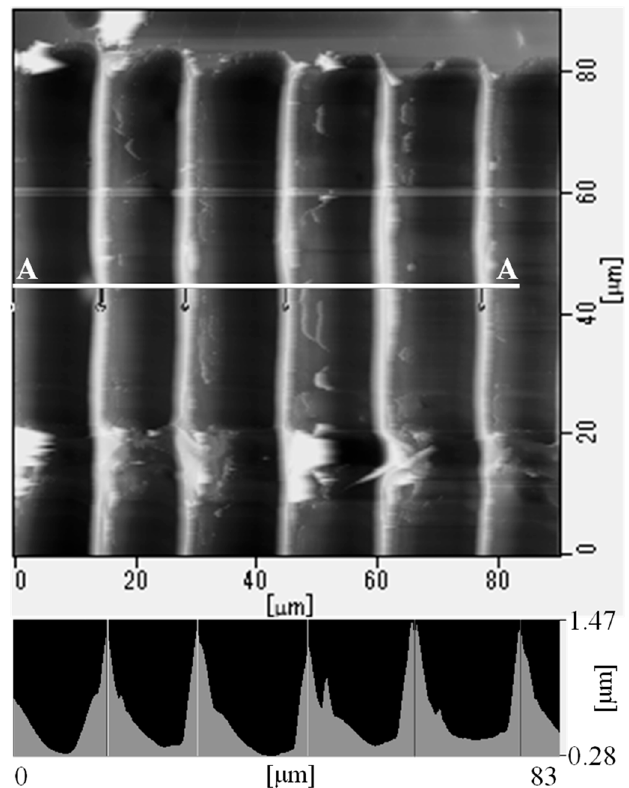
Figure 4. SPM images of the SS-processed Cu/PET film at W = 4.00 N ( T = 7.73 N, θ = 150.0°): surface image (top) and cross-sectional profile at the A–A section in the surface image (bottom). Processing conditions: V = 10.0 mm/min and L = 1.0 mm.